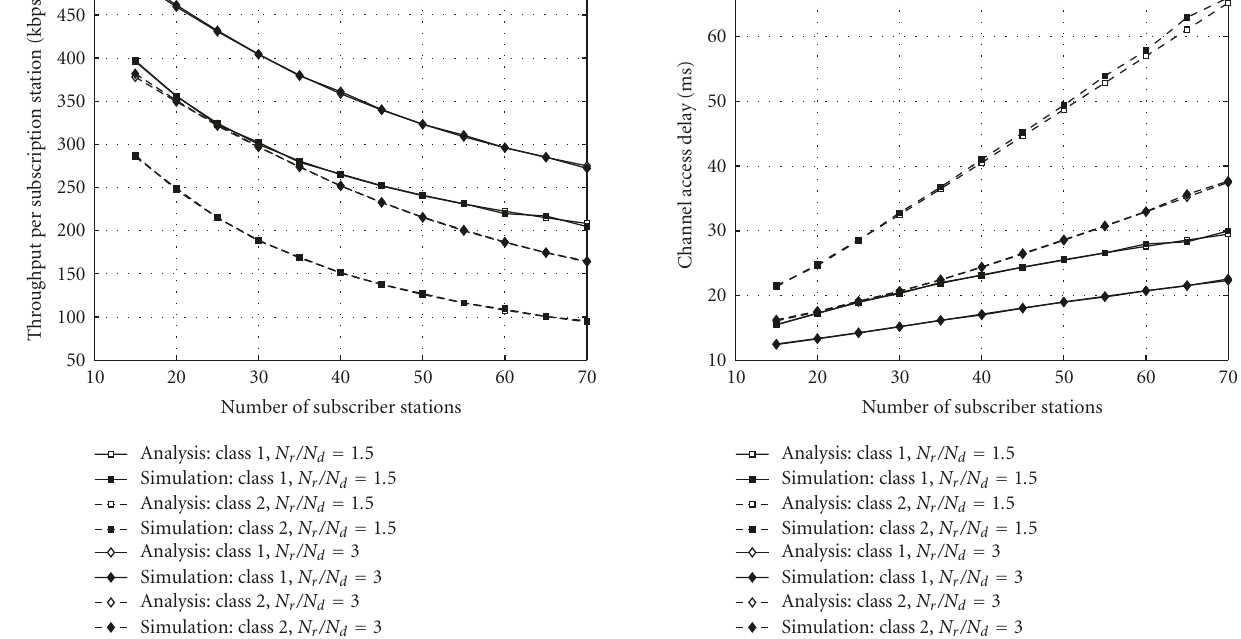
Figure 4: Throughput of single SS versus the number of SSs with equal bandwidth allocation priority and di ff erentiated channel